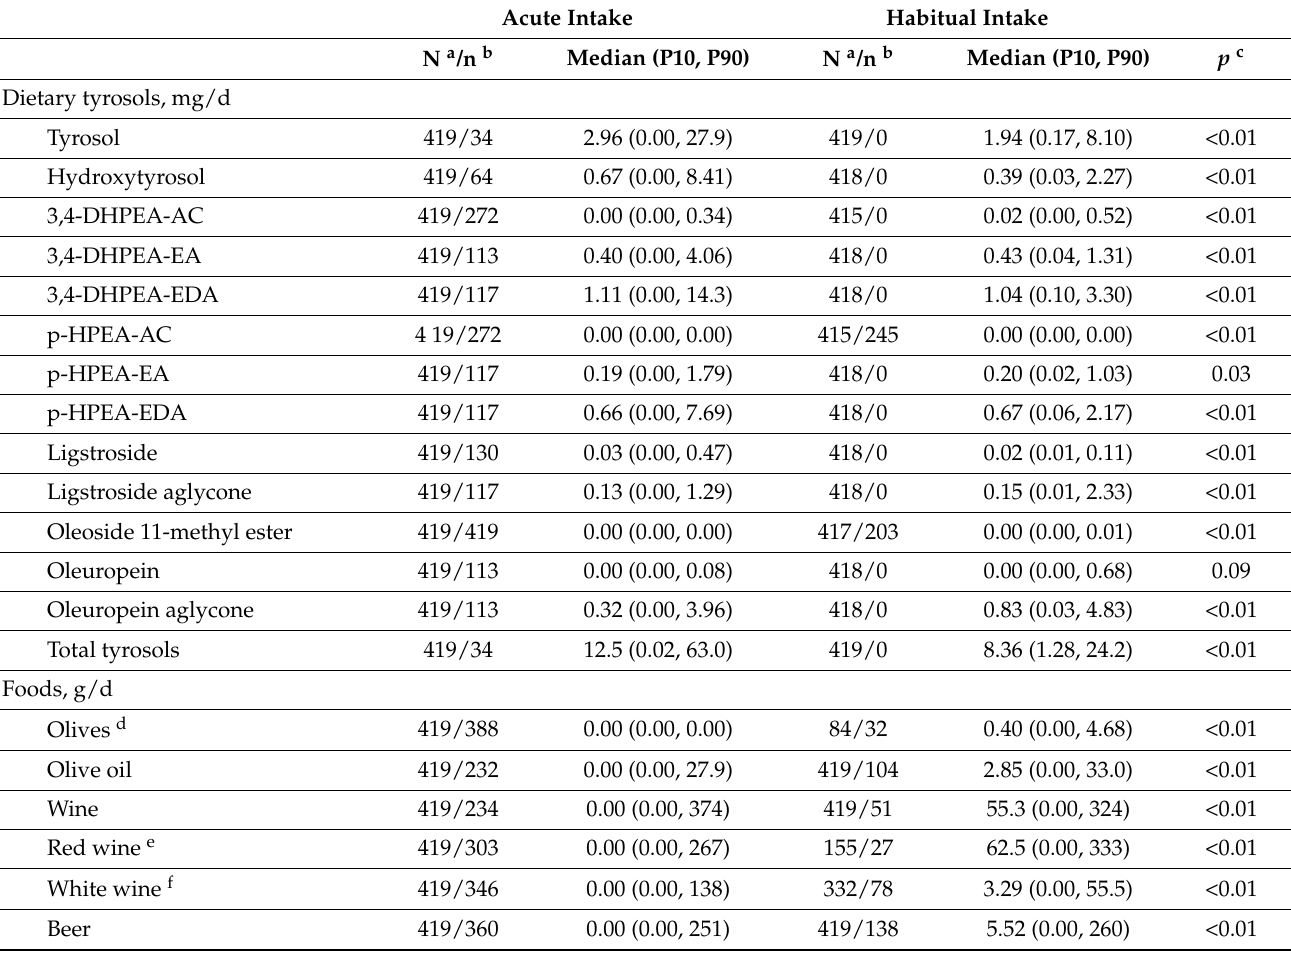
Table 2. Medians and 10th (P10) and 90th (P90) percentiles of acute and habitual intake of dietary tyrosols and their main food sources in participants (n = 419) of the EPIC